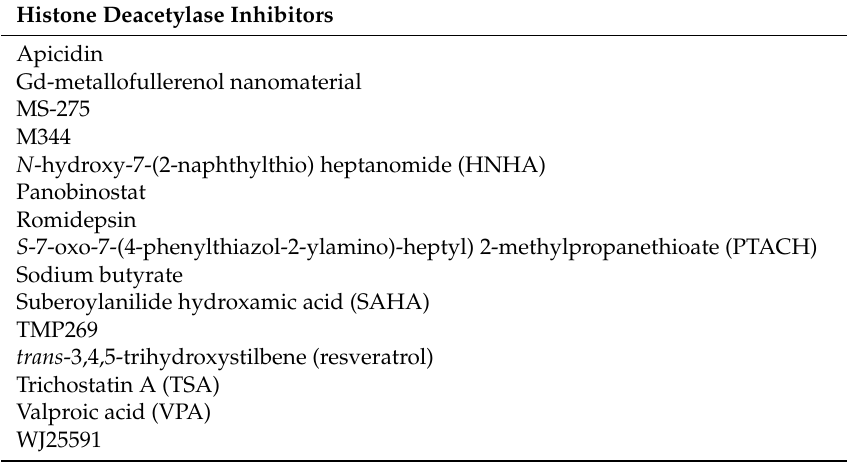
Table 1. List of histone deacetylase